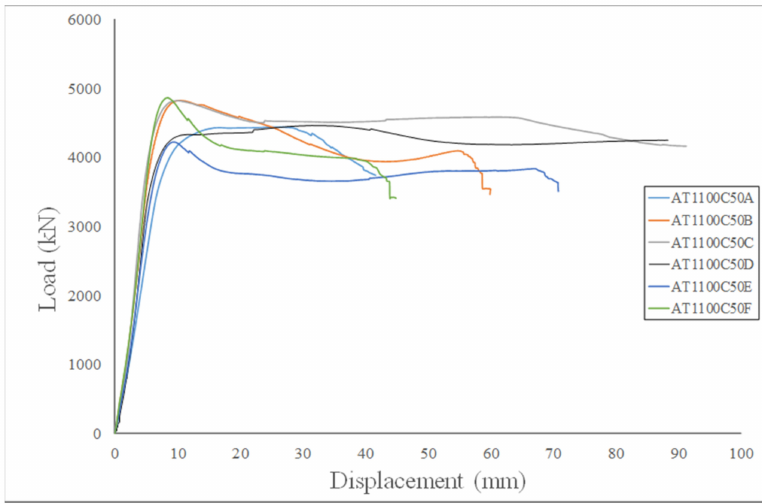
Figure 8. Load versus displacement curves of specimen AT